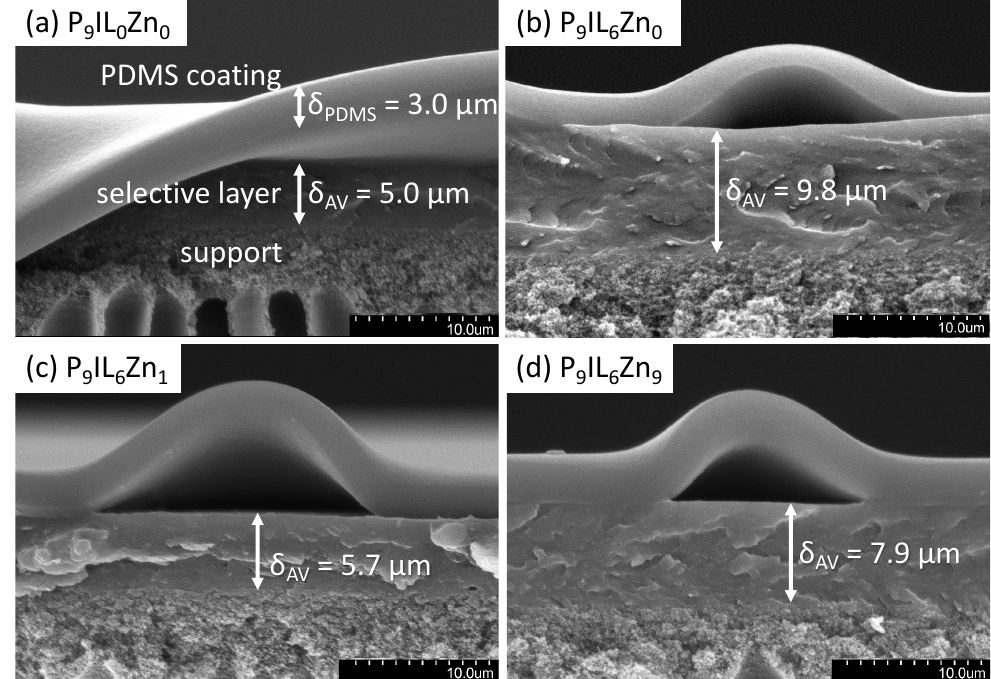
Figure 7. Cross-sectional SEM images depict the composite layered morphology of the membranes: ( a ) P 9 IL 0 Zn 0 , ( b ) P 9 IL 6 Zn 0 , ( c ) P 9 IL 6 Zn 1 , ( d ) P 9 IL 6 Zn 9 . Arrows indicate the corresponding layer thicknesses of PDMS sealing and selective